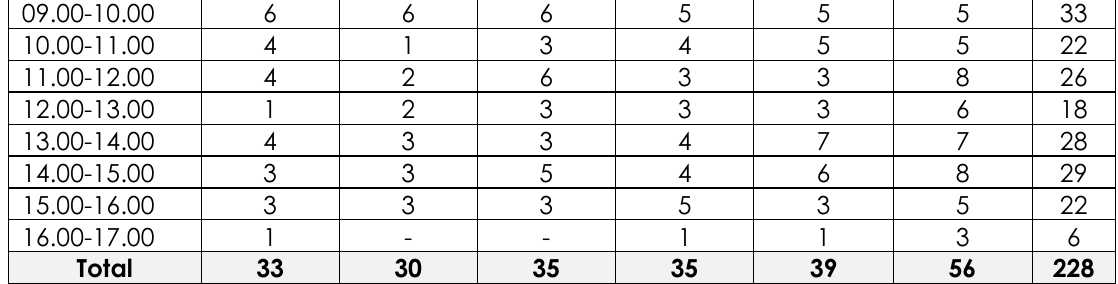
Table 2. Total Customer Arrivals Per Hour